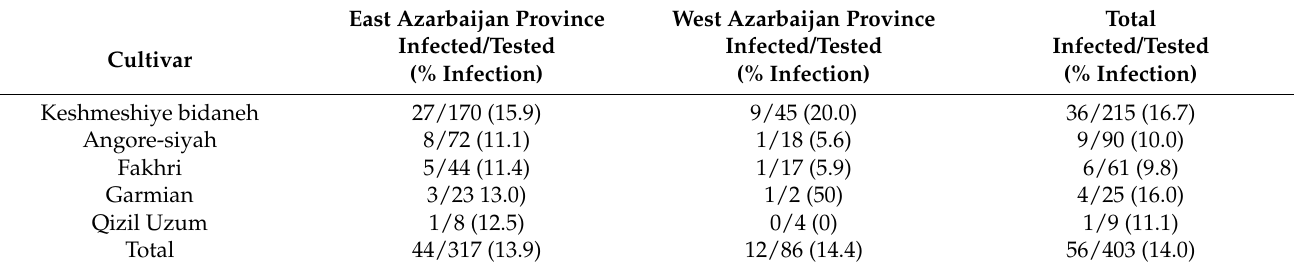
Table 1. Presence and distribution of GVA in grapevine samples in the East and West Azarbaijan